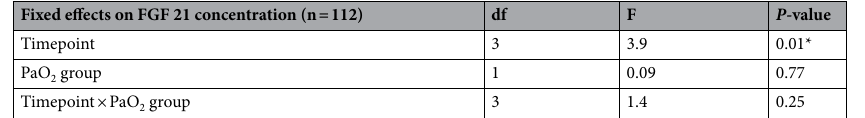
Fixed effects on FGF 21 concentration (n = 112) df F P -value